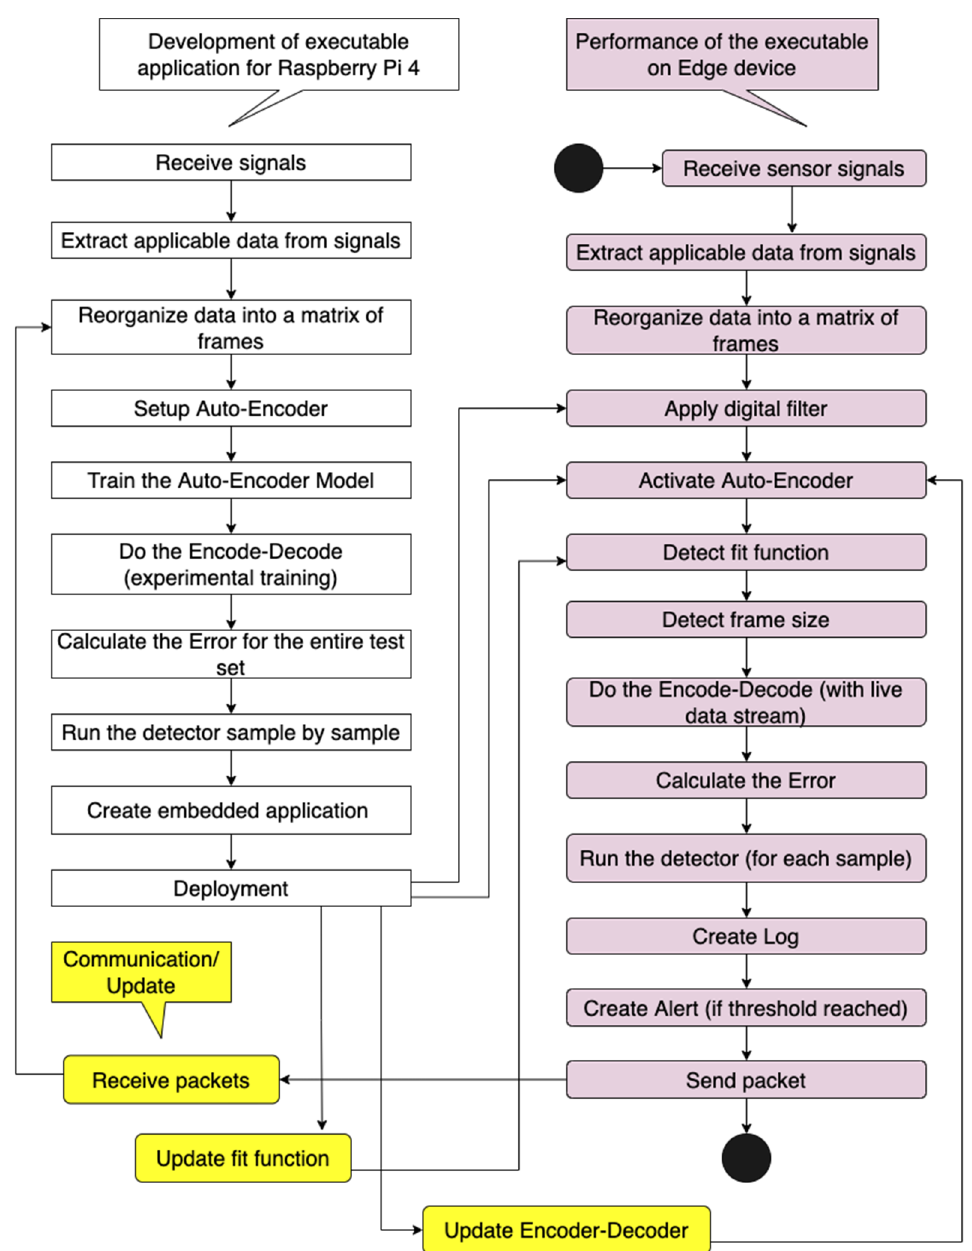
Figure 3. Data analytics algorithm used to develop the training method and embedded to the Edge computing unit.